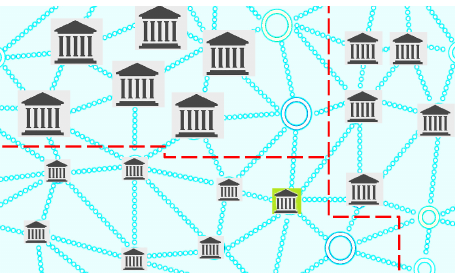
Figure 4. Subnetwork C s